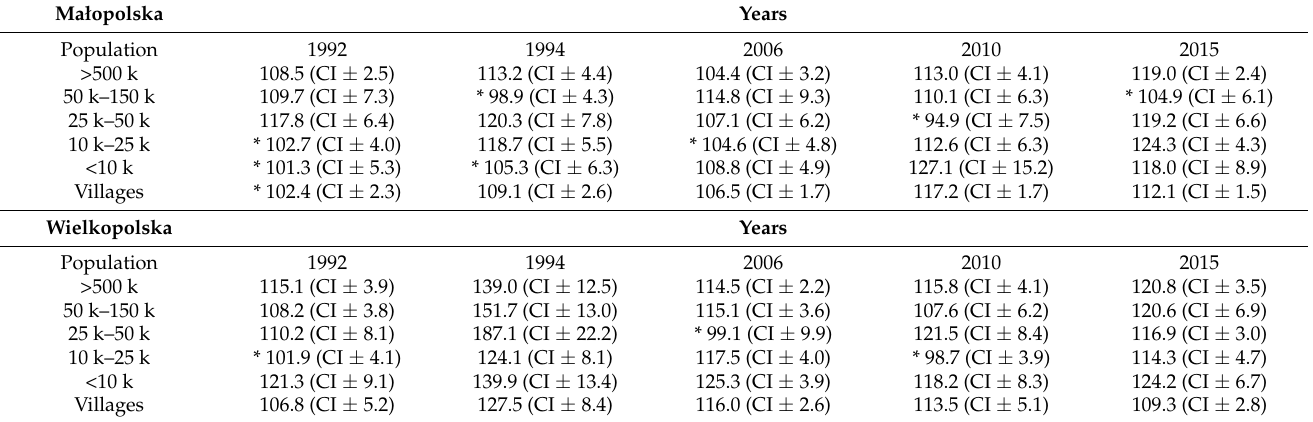
Table 6. Heat-related mortality during the studied five summer periods calculated as percentage of the expected number of deaths during the time heatwave occurred. Subpopulation age 65 and older is analyzed. The 90% confidence intervals are in brackets. Statistically insignificant results are marked with *.